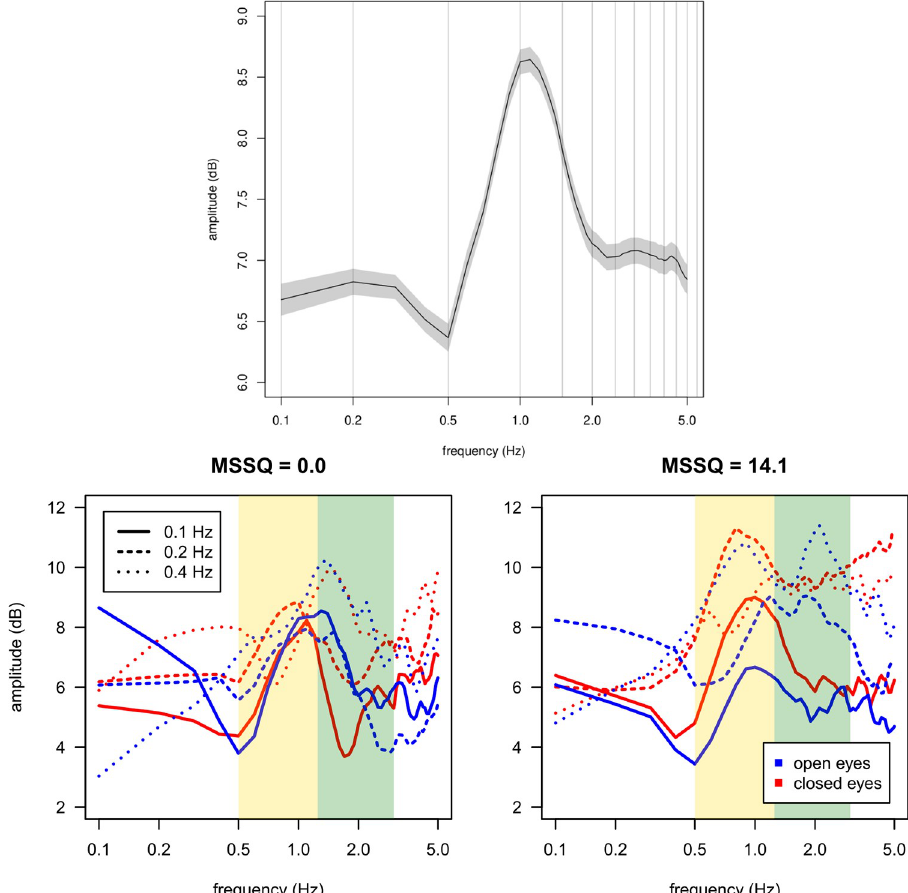
Fig 3. Top: Average of the PC1 eigenvectors for all participants. Bottom: Dependency of the spectral balance on the MSSQ, frequency, and visual conditions. Left panel: Examples of PC1 for selected participants with little to no differences in spectral bump between EO and EC (left) and greater differences (right). The eigenvectors for each case are shown in blue for the EO condition and in red for the EC conditions. Different types of lines were used for the different perturbation frequencies with the continuous one for 0.1 Hz, the dashed one for 0.2 Hz and the dotted one for 0.4 Hz. The yellow and green vertical stripes correspond to the frequency bands used for computing the spectral balance